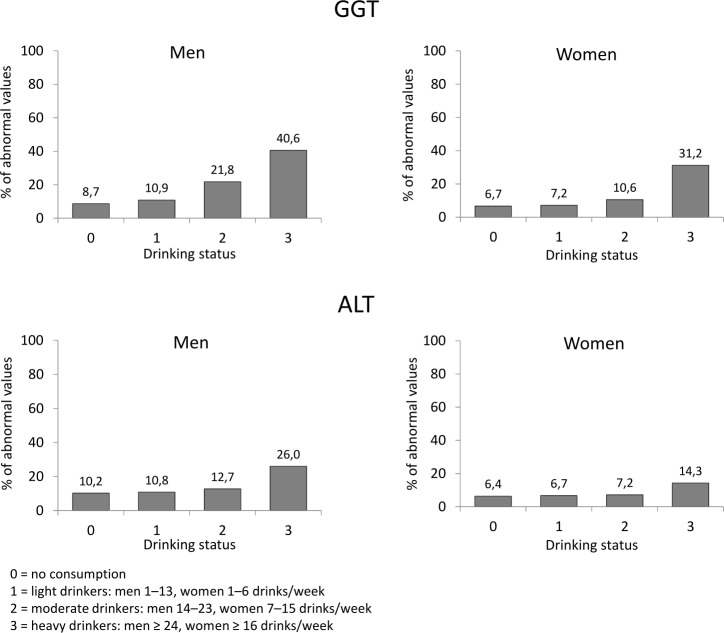
Incidence of abnormal GGT and ALT activities in groups classified according to drinking status.